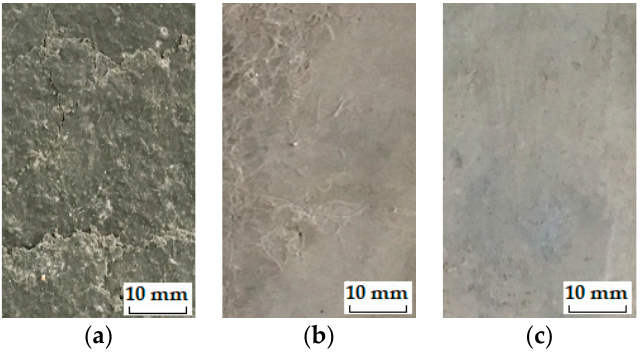
Figure 13. The surface appearance of typical ECC mixtures: ( a ) Mix. 6 after 50 cycles; ( b ) Mix. 4 after 250 cycles; ( c ) Mix. 9 after 300 cycles.